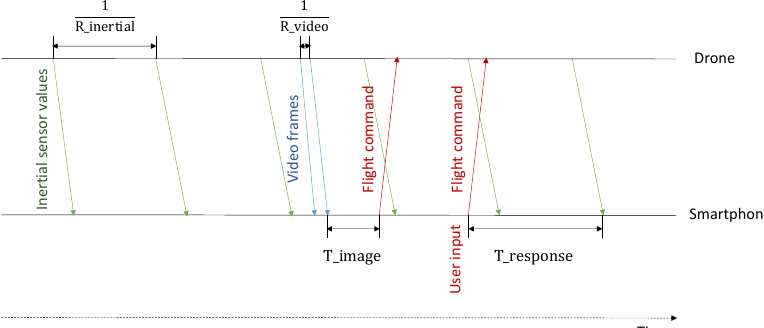
Figure 3. Times to consider in a vision-based distributed navigation system: Inertial sensor values are sent periodically from the drone to the smartphone, as well as video frames. After processing an image, the navigation logic decides upon the next flight maneuver and sends a flight command to the drone. At any point in time, the human user may interfere and send an overruling flight command to the drone via interacting with the